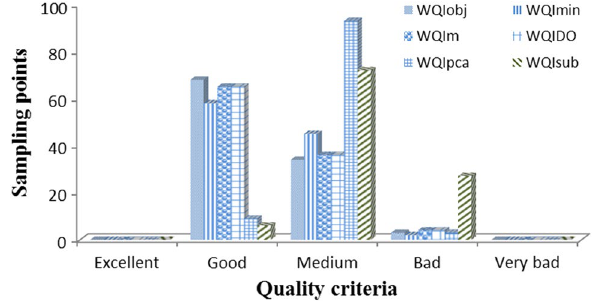
Fig. 10 Quality categorization of surface water samples in upper